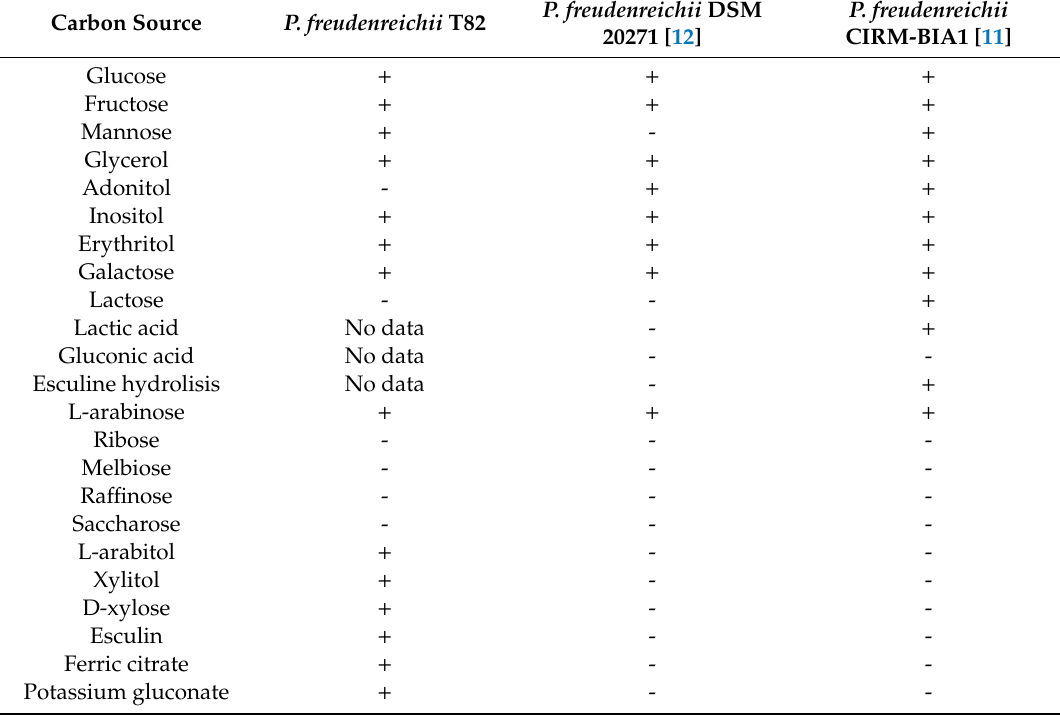
Table 3. Propionibacterium freudenreichii carbon substrate